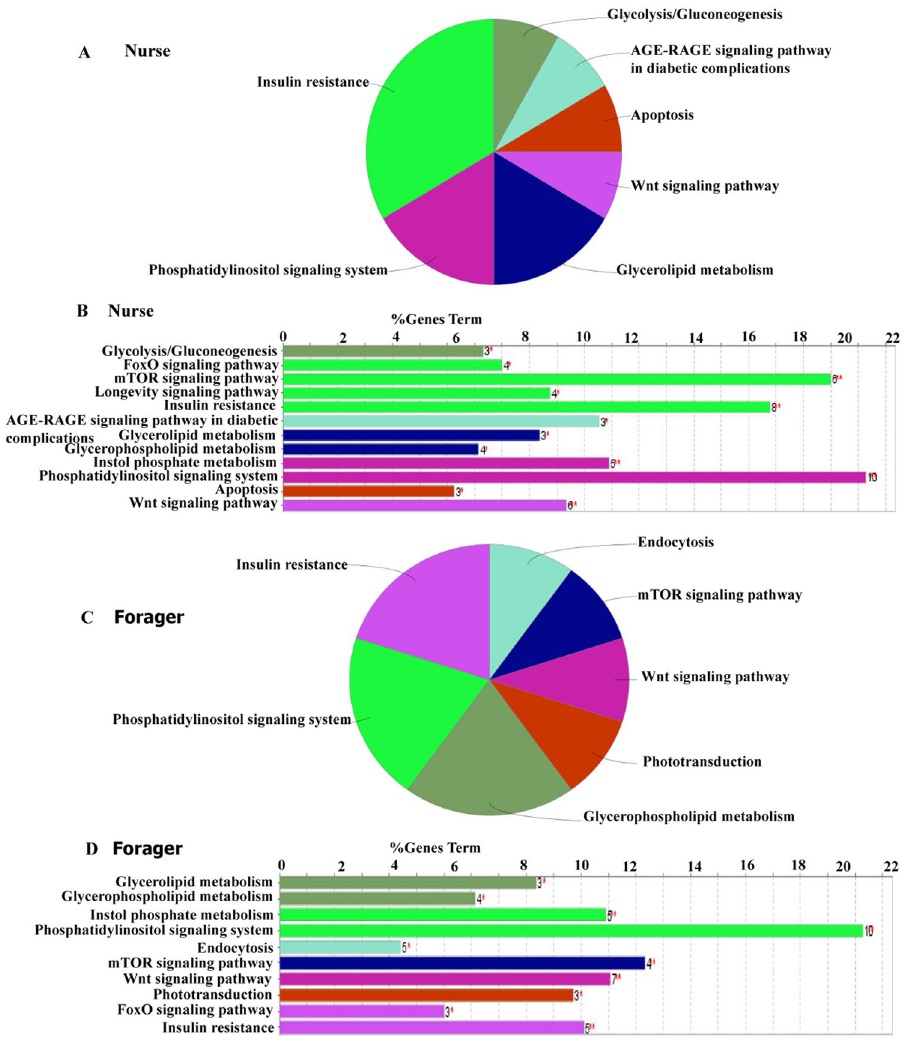
Figure 5. GlueGO analysis of protein kinases from the brain of honeybee workers ( A.m.ligustica ) which are identified in our experiment. GO biological process and KEGG pathway terms (first letter capitalized) specific for phosphoproteins from the brain of the honeybee workers ( ** p < 0.01; * p < 0.05). The numbers of corresponding genes associated with a specific term are indicated. The percentage of genes associated with a specific term is listed on the bars. ( A–D ) enriched ClueGO and KEGG pathway terms of phosphoproteins identified. A and B represents nurse bee and C and D represents forager